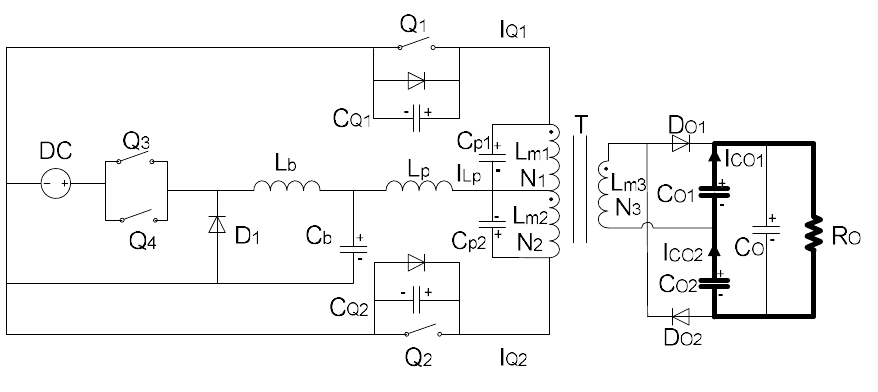
Figure 8. Equivalent circuit of mode III.